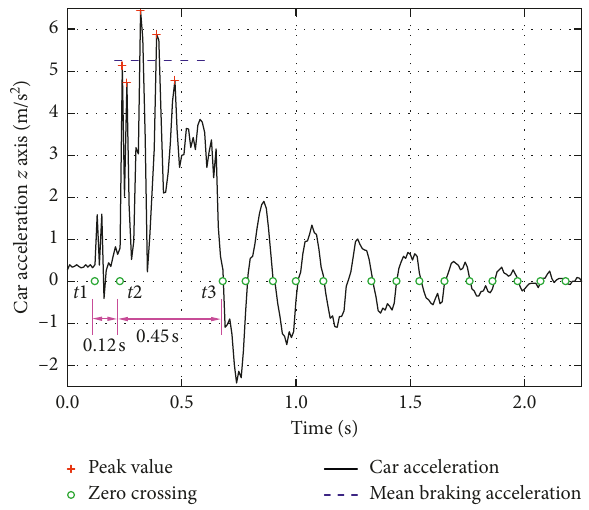
Figure 8: Acceleration test results of unloaded downlink emer- gency braking. Table 7: Larger peak